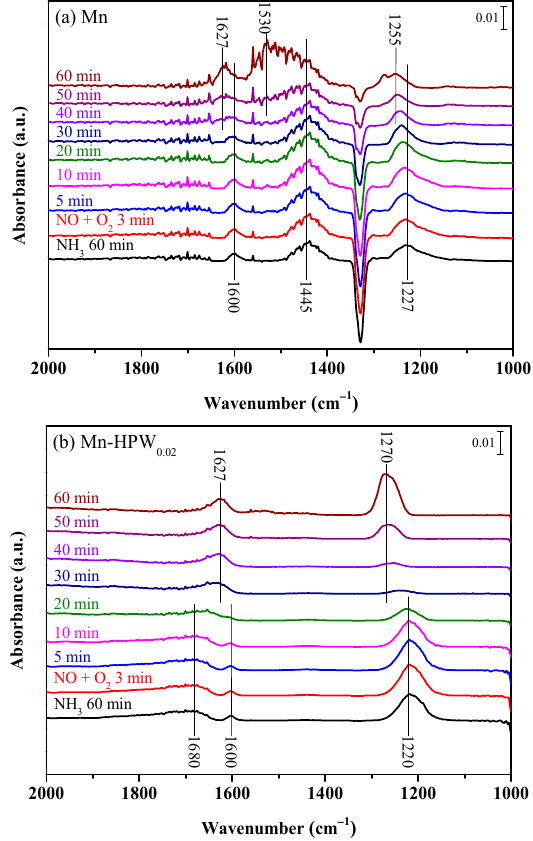
Figure 12. DRIFT spectra obtained by subtracting the corresponding background spectra of NO + O 2 reacted with pre-adsorbed NH 3 species at 120 °C on Mn ( a ) and Mn-HPW 0.02 ( b ).